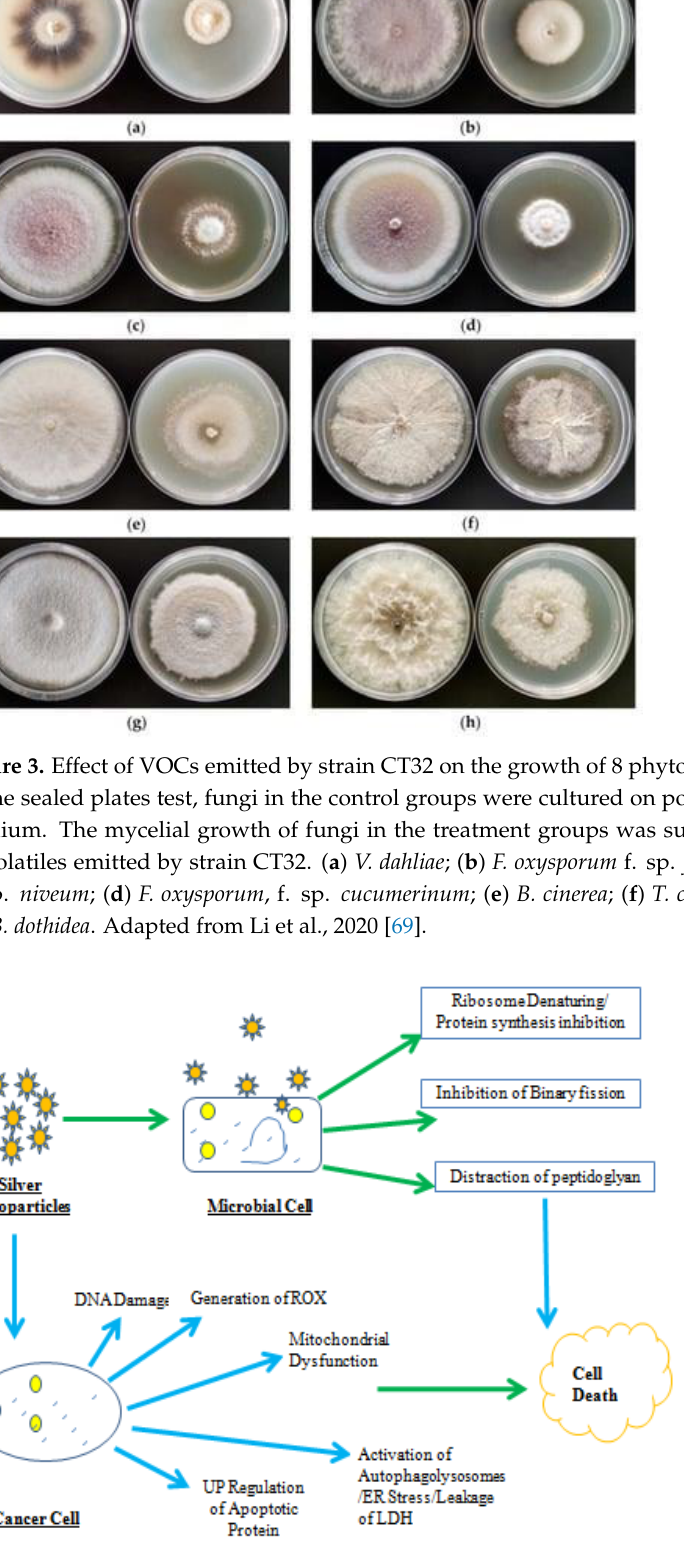
Figure 4. The silver nanoparticles synthesized by Lysinibacillus sp. and their potential possible applications.